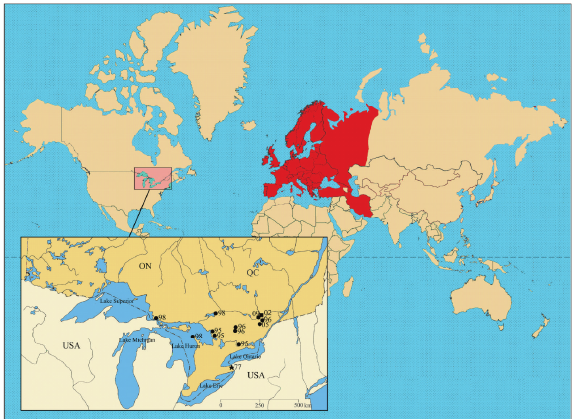
Figure 6: Old World distribution of Neocrepidodera ferruginea according to the countries listed in the catalogue of L¨obl and Smetana [31]. Insert: distribution of Neocrepidodera ferruginea in North America. Star: Niagara Falls (Ontario), where the first speci- mens were collected. Solid circles: collection localities with collec- tion years of 77 (1977) 95 (1995), 96 (1996), 98 (1998), 02 (2002), and 05 ( = 2005). Solid square: all collections in Aylmer (Qu´ebec) grouped